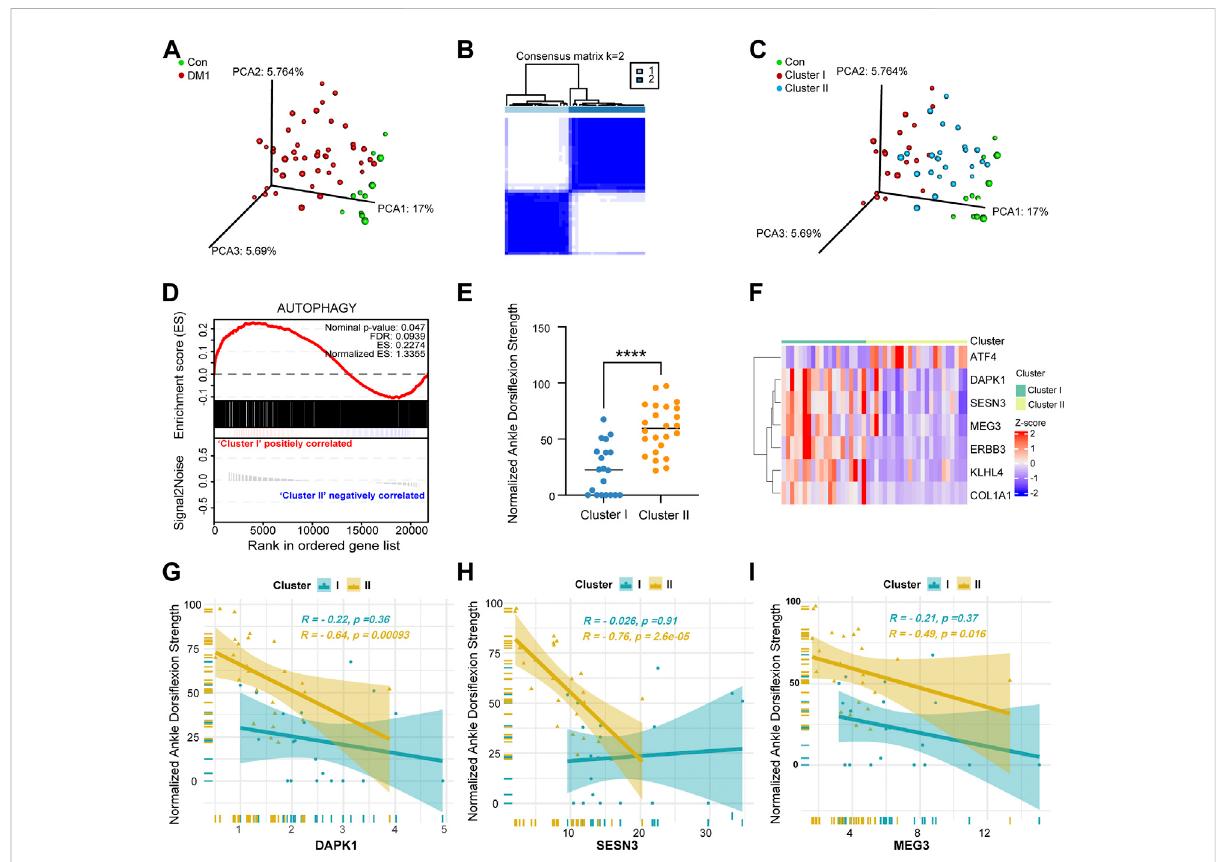
FIGURE 4 Identi fi cation of molecular subgroups in DM1 based on autophagy-related gene sets. (A) Principal component analysis (PCA) based on 1,888 ATGs showing a higher heterogeneity between DM1 and control group in GSE86356. (B) The two consensus molecular subgroups were identi fi ed by consensus clustering analysis in DM1. (C) PCA plots of different group based on 1,888 ATGs colored by group types. (D) The GSEA plot shows signi fi cant enrichment (NES = 1.3355, FDR = 0.0939) of ATGs in DM1 vs. Con. (E) The scatter plots showing the differential clinical signatures of genes between the two molecular subgroups. (F) Heatmap of 7 hallmark genes between cluster I and cluster II. (G – I) The line chart of correlation coef fi cients performed that the gene expression of DAPK1, SESN3 and MEG3 relative to normalized ankle dorsi fl exion strength between the two subgroups of DM1. Con, control; DM1, myotonic dystrophy type 1. **** p <